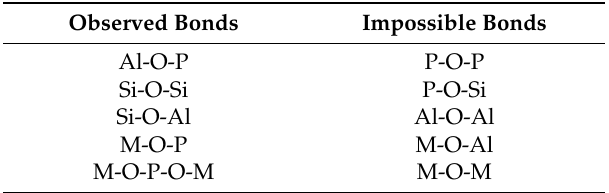
Table 2. Bonds observed in zeotypes and bonds not possible in zeotypes 1